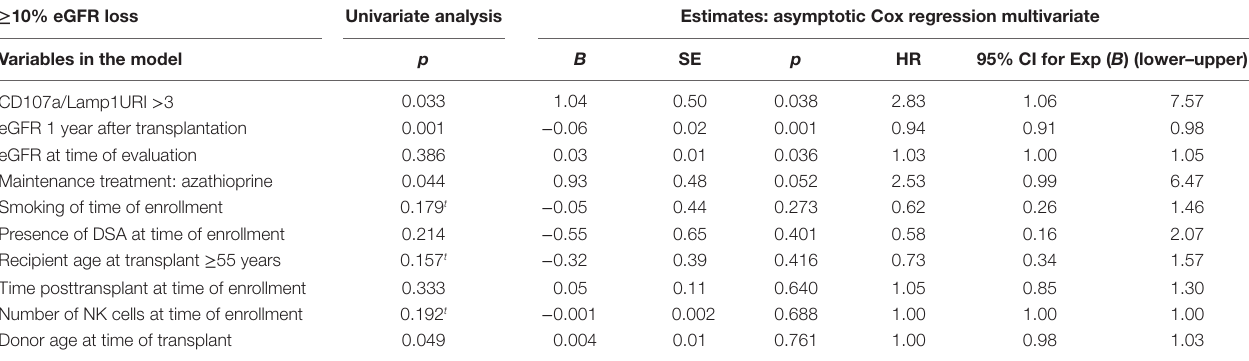
TaBle 2 | Univariate and multivariate analysis of factors associated with the progression to cKD at 1 year post-enrollment into the study. ≥ 10% egFr